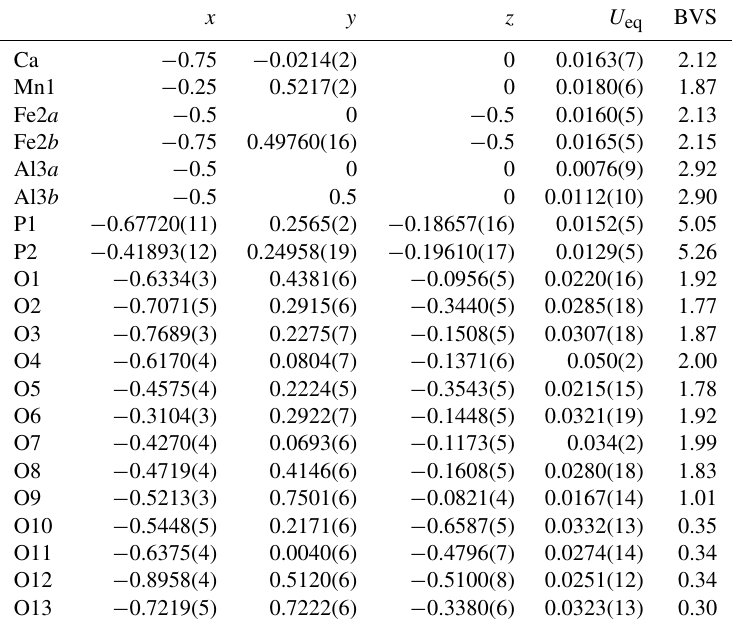
Table 4. Atom coordinates, equivalent isotropic displacement parameters (Å 2 ) and bond valence sums (BVS in valence units) for whiteite-